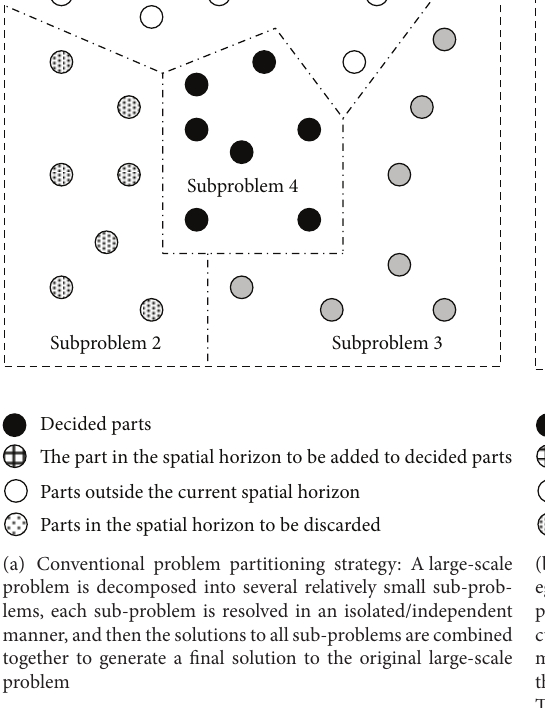
Figure 3: Illustration of Spatial Receding Horizon Control